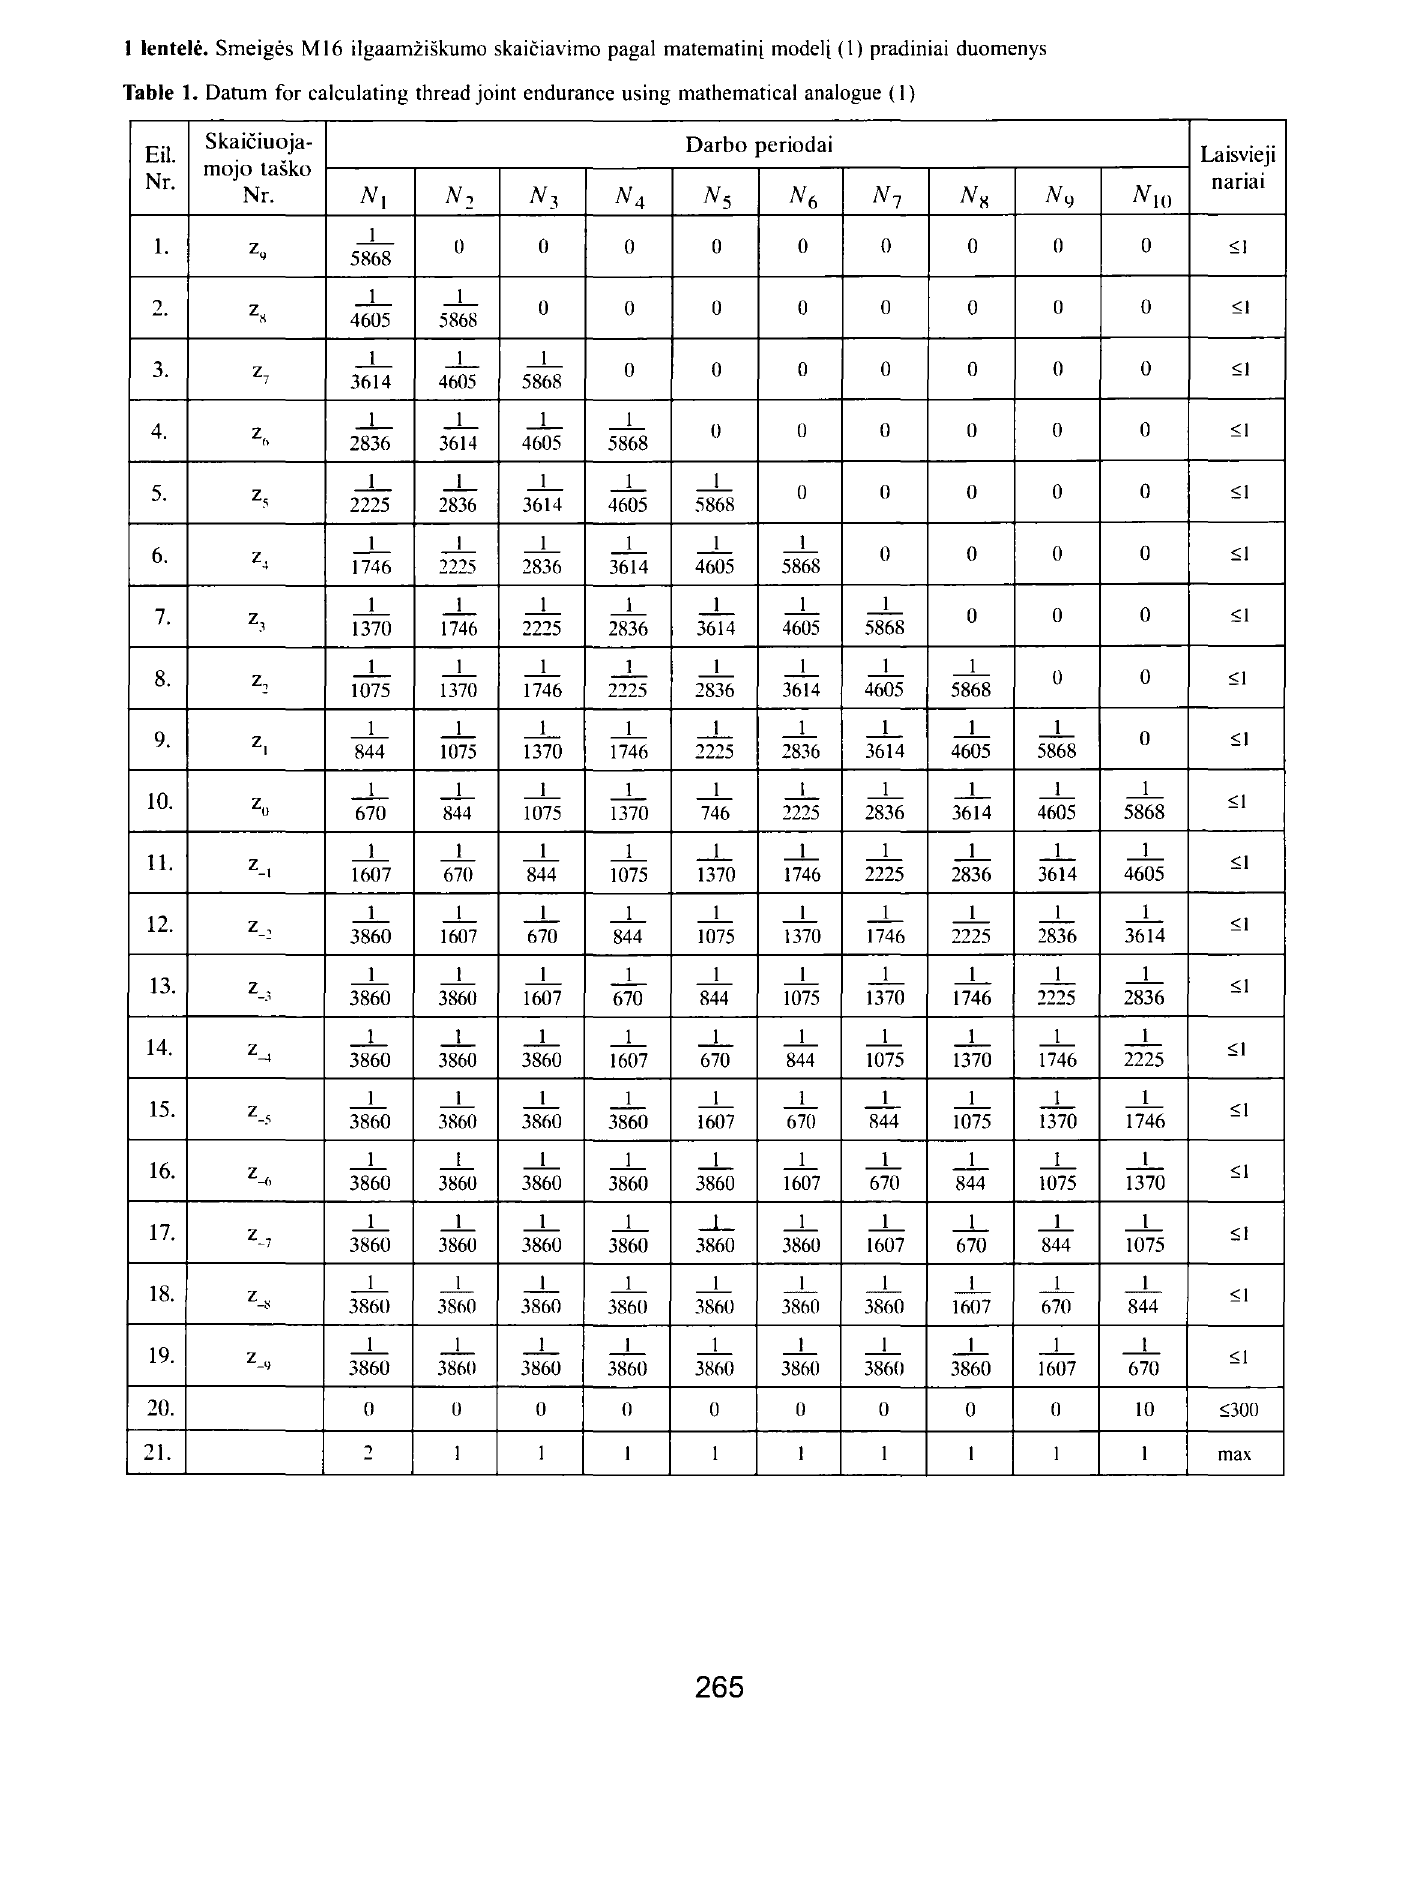
Table I. Datum for calculating thread joint endurance using mathematical analogue ( I) SkaiCiuoja- Darbo periodai Eil. mojo Nr.